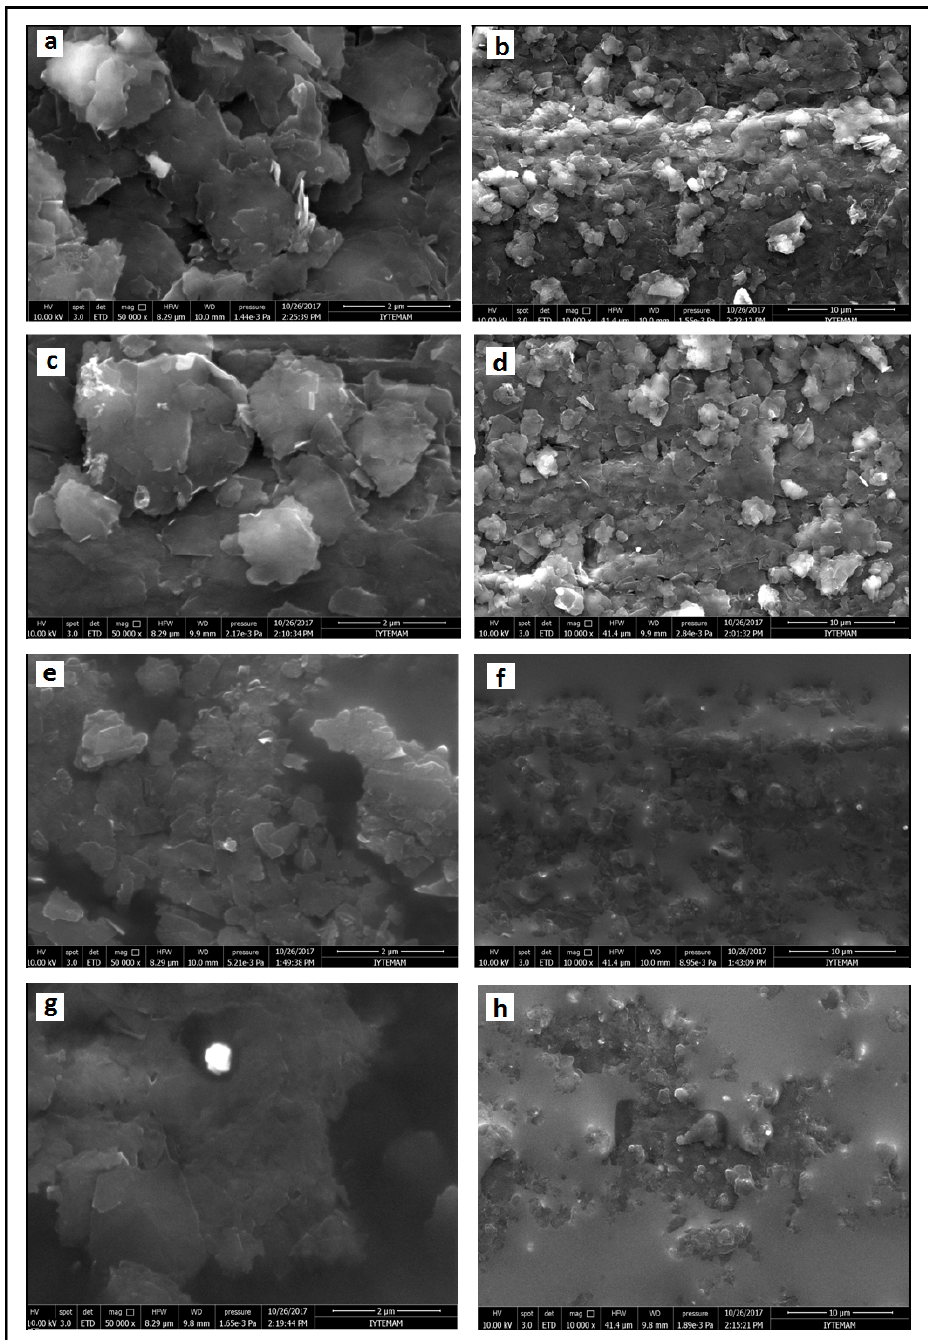
Figure 1. SEM images of PGE ( a , b ), CoPc-PGE ( c , d ), IL-PGE ( e , f ), and CoPc-IL-PGE ( g , h ) using the identical acceleration voltage of 10 kV with a resolution of 2 µm and 10 µm, respectively.